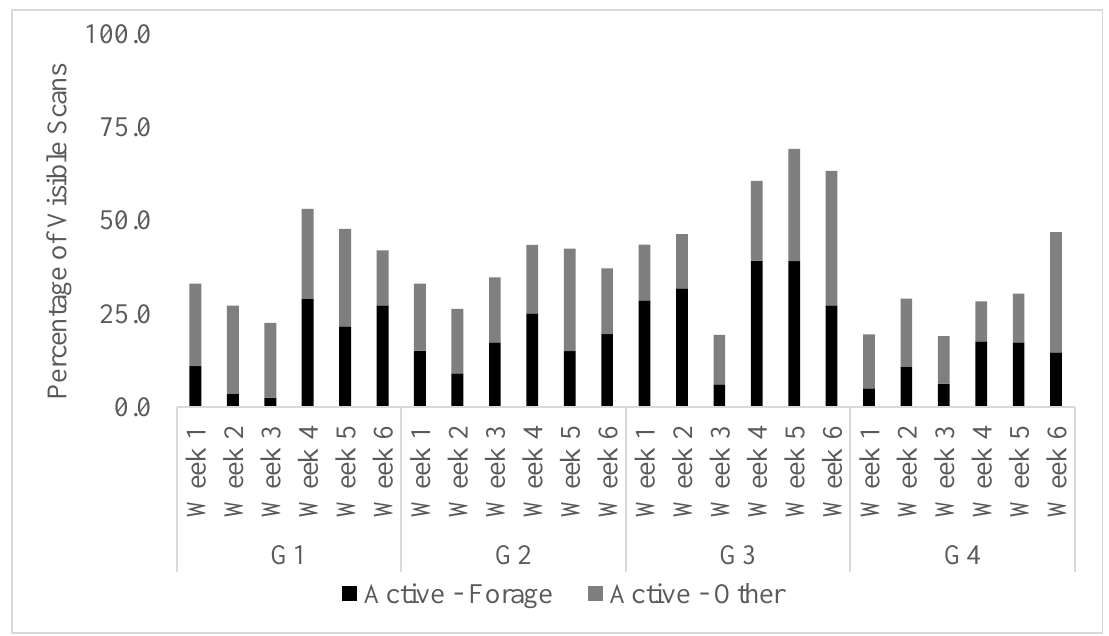
Figure 3 . Individual weekly averages for foraging and activity levels throughout the study. Note. Entire bar equals the overall percentage of time spent active per week, black portion of bar includes only percentage of that time spent foraging per